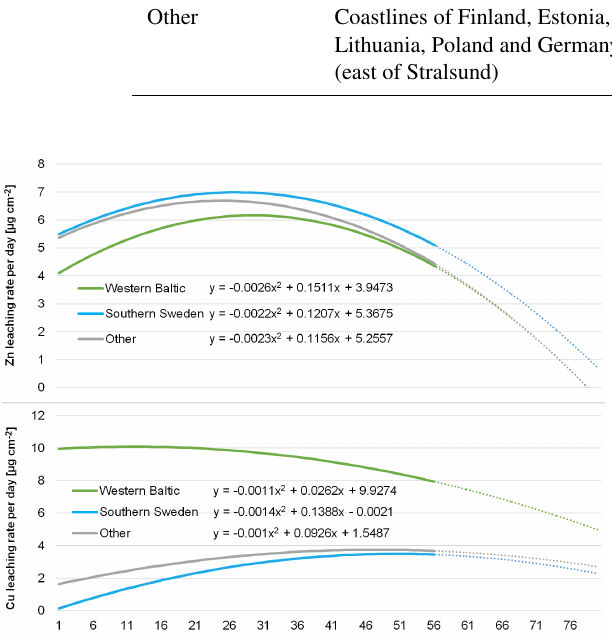
Figure 2. Cu and Zn contaminant leaching rates as a function of days spent in the water (at sea) for different areas of the Baltic Sea, as described in Lagerström et al.